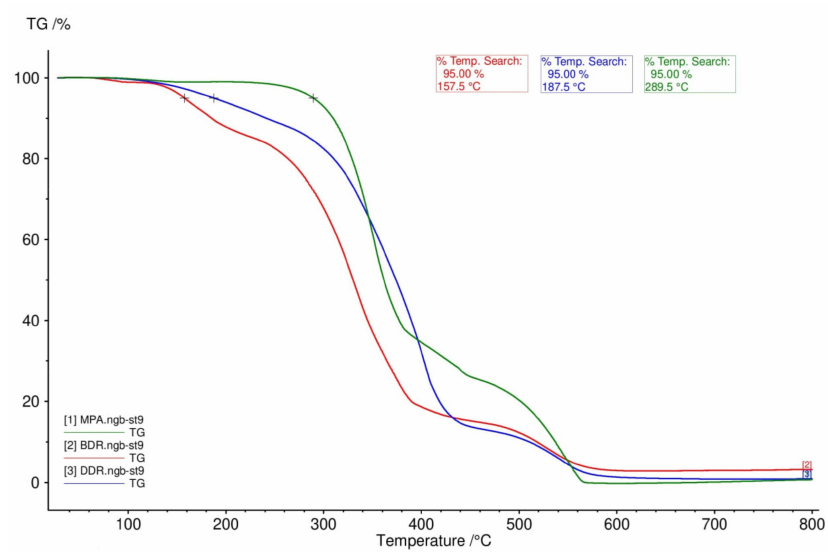
Figure 3. The TG curves of MPA and its diesters blue, MPA; red BDR; green